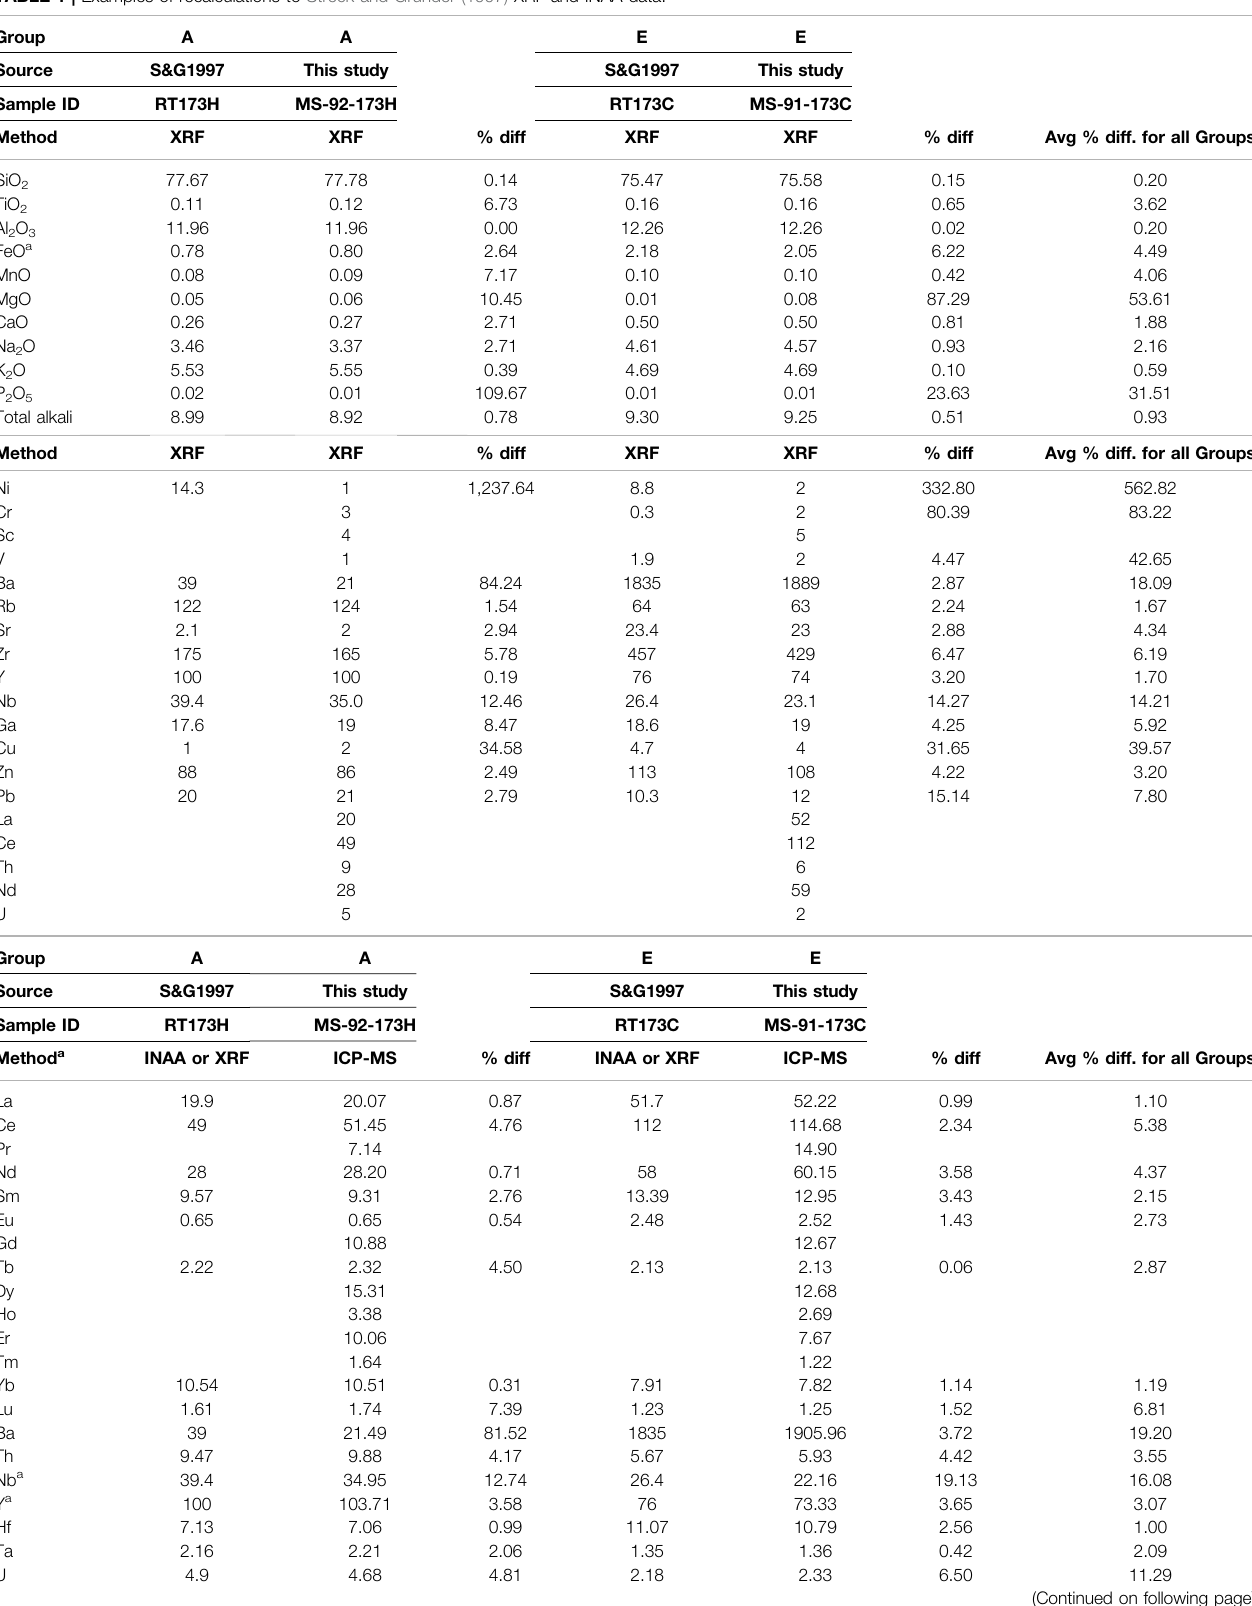
TABLE 1 | Examples of recalculations to Streck and Grunder (1997) XRF and INAA data. Group A A E E